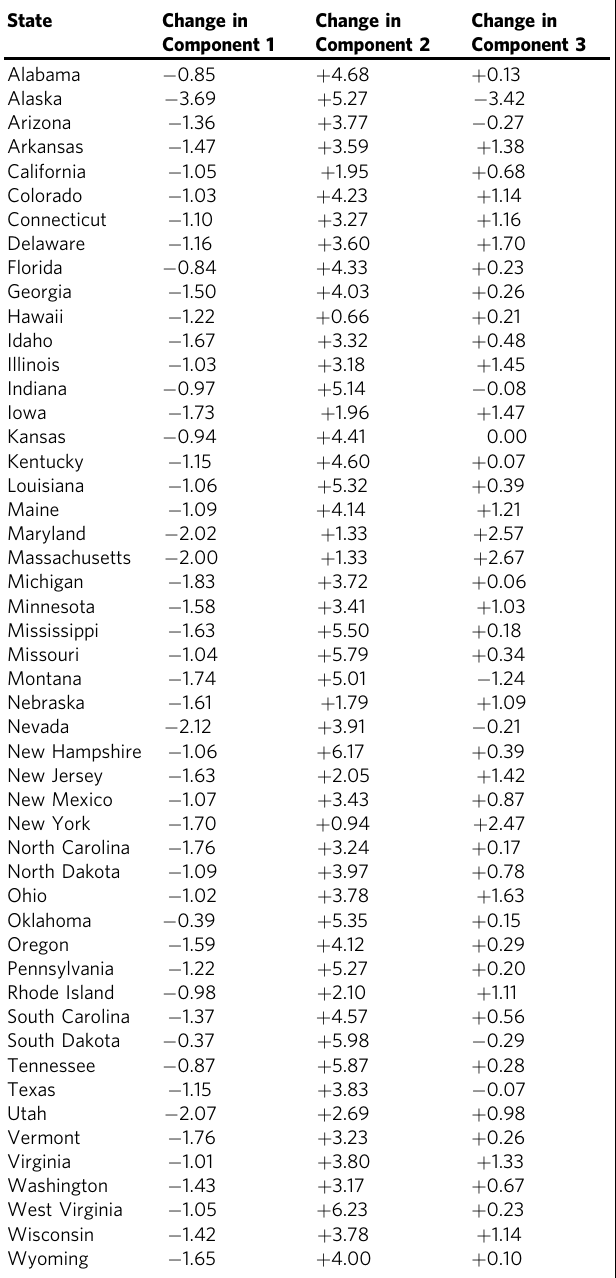
Table 2 Change in each component per state between 1998 and